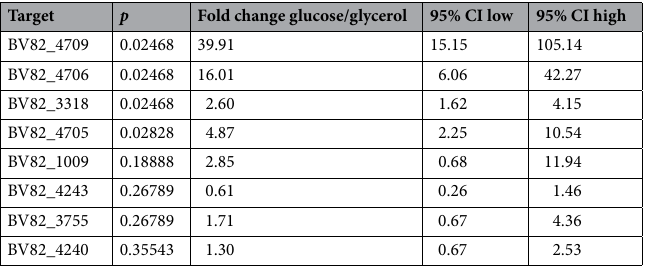
Table 3. Student t-test results for the comparison of expression of P482 target genes under various carbon source (glucose or glycerol).